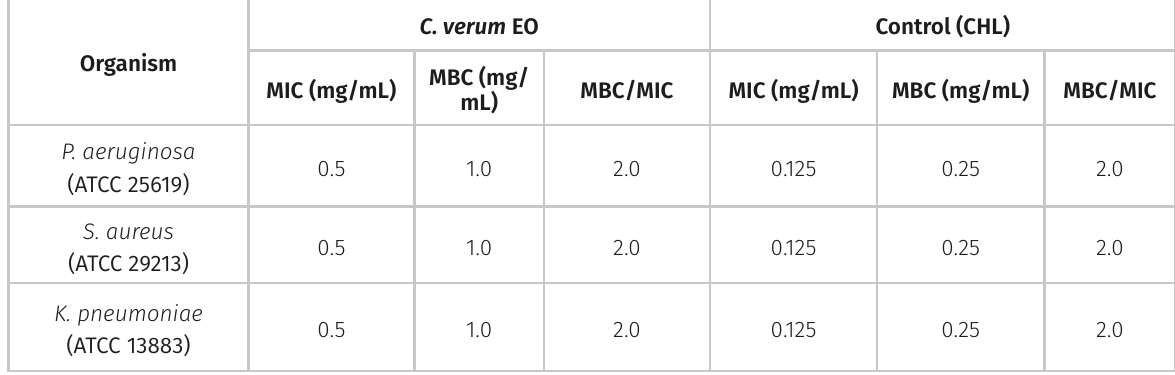
Table I. Results of MIC and MBC of test bacteria. Experiment was made in triplicates with three individual experiments. CHL was used as positive